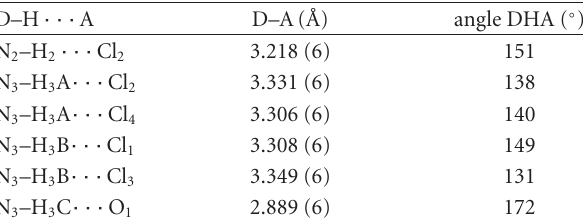
Figure 1. Selected bond lengths and hydrogen bond short contact distances are presented in Tables 2 and 3, respectively.